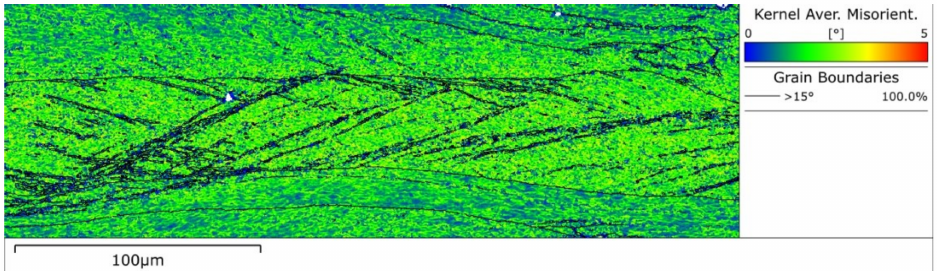
Figure 15. Kernel average misorientation map of the dynamic microstructure after deformation at Z = 3.34 × 10 30 (700 ◦ C, 10 s − 1 ) and strain of 0.55. (Black lines denote high-angle grain boundary having the misorientation greater than 15 ◦